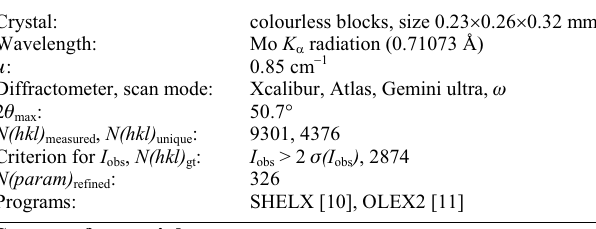
Table 1. Data collection and handling.